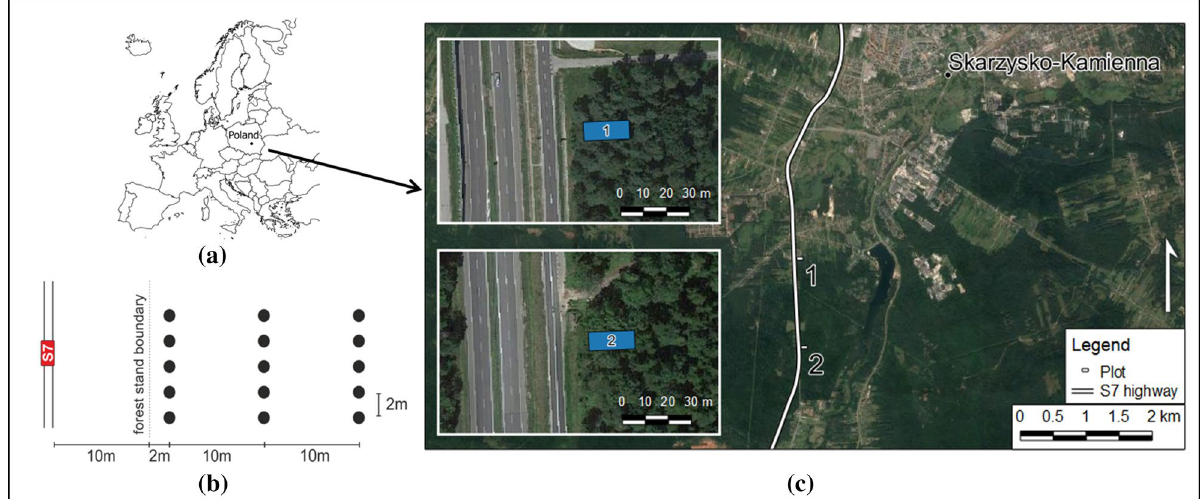
Figure 1. Location of the study site: ( a ) location of Poland in Europe; ( b ) sampling scheme; ( c ) location of study sites. Maps ( a ) and ( c ) were generated using QGIS software 25 (QGIS, Version 2.18.25; http:// www. qgis.